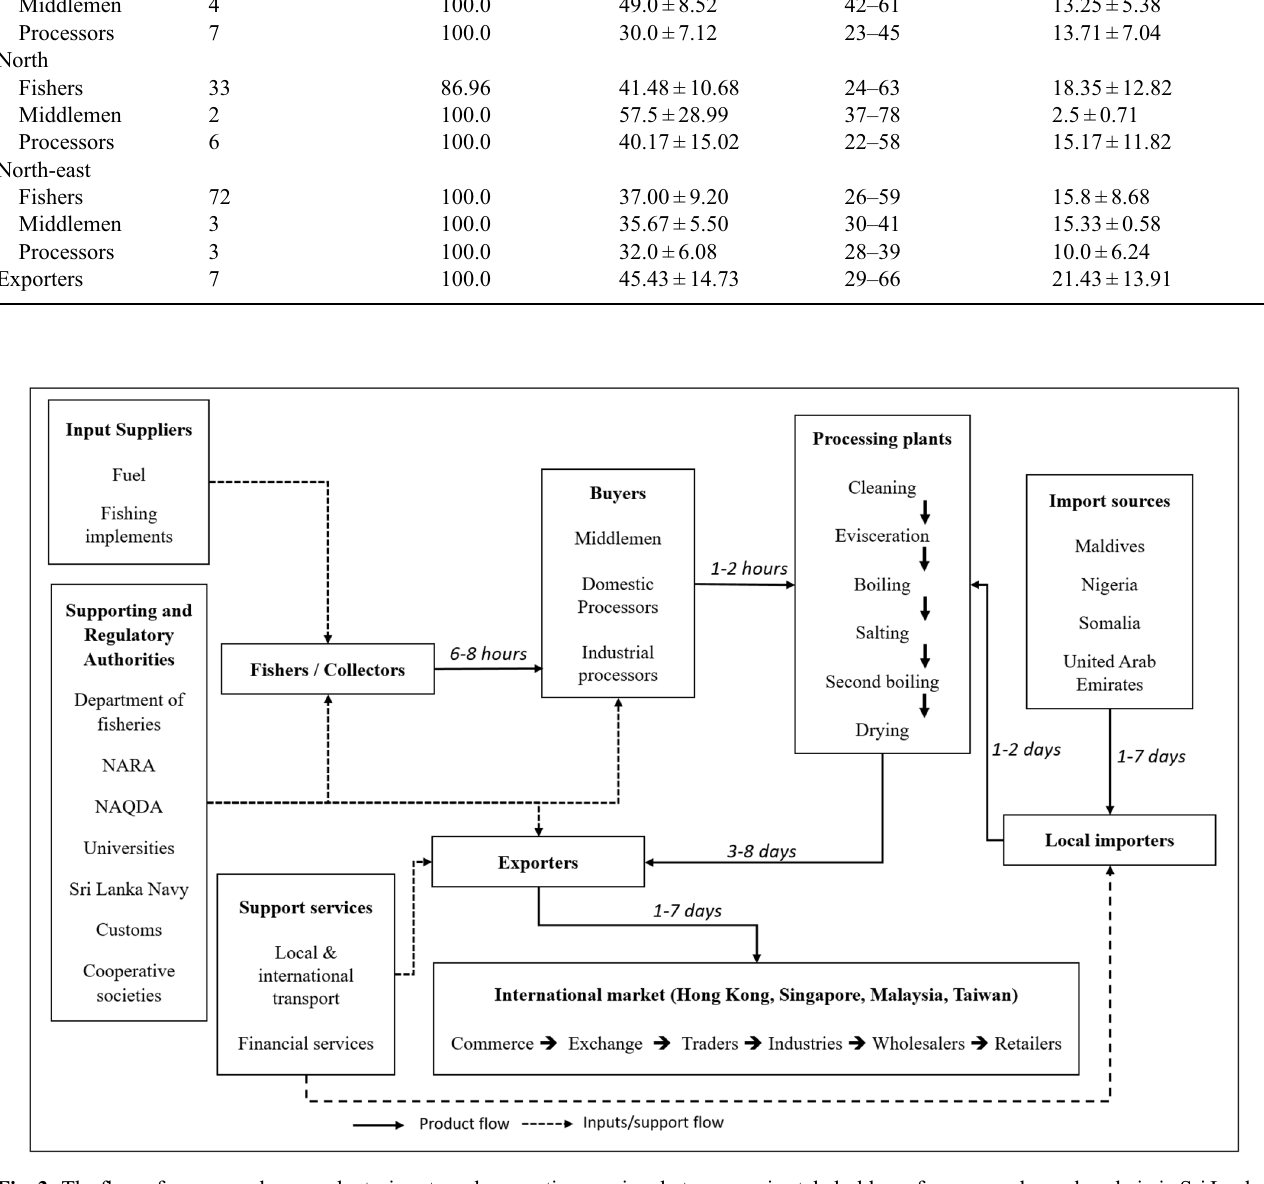
Fig. 3. The fl ow of sea cucumbers products, inputs and supporting services between main stakeholders of sea cucumber value chain in Sri Lanka.